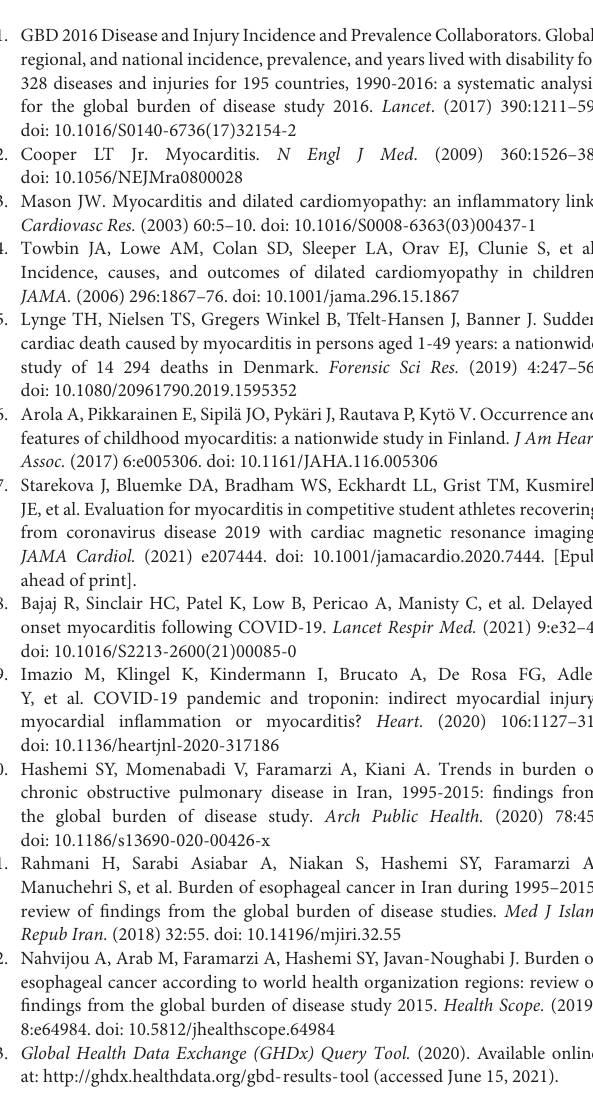
Supplementary Figure 1 | The global disease burden of myocarditis for both genders in 195 countries and territories. (A) The relative change in incident cases